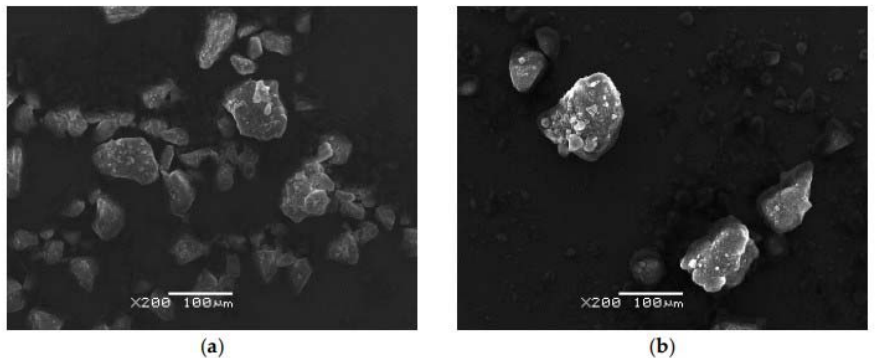
Figure 6. SEM images of diamond nanoparticles): ( a ) pure detonated nanodiamond particles (DND); and ( b ) plasma ‐ chemically modified detonation nanodiamond particles (MDP1).